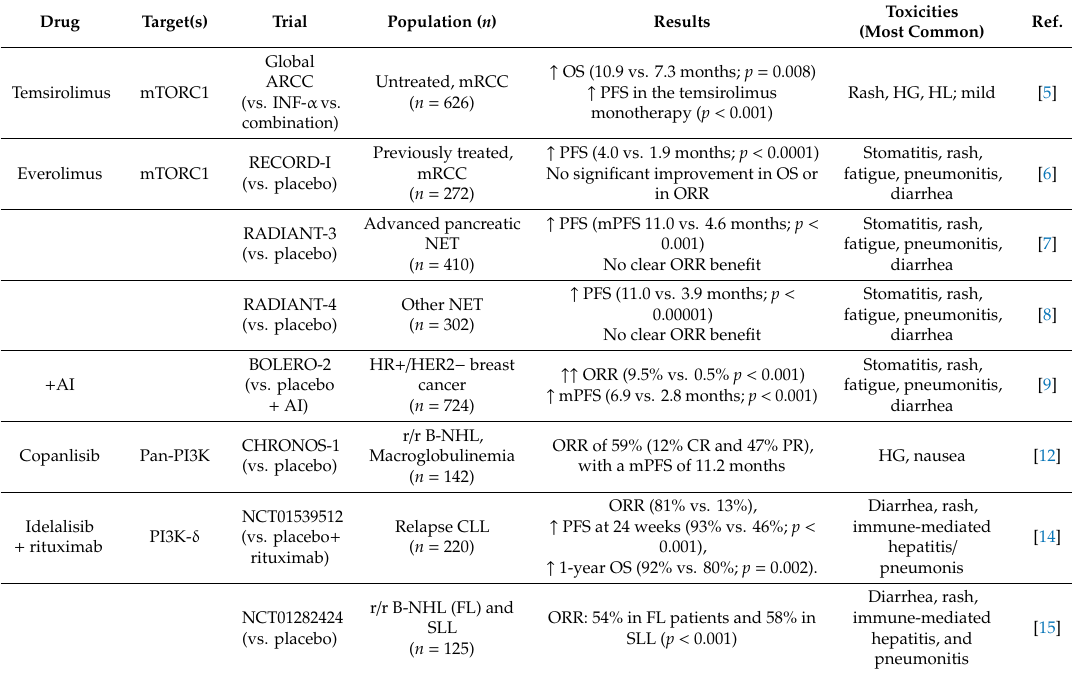
Table 4. Selected ongoing clinical trials of PI3K / AKT / mTOR inhibitors involving PIK3CA mutation as a selection population